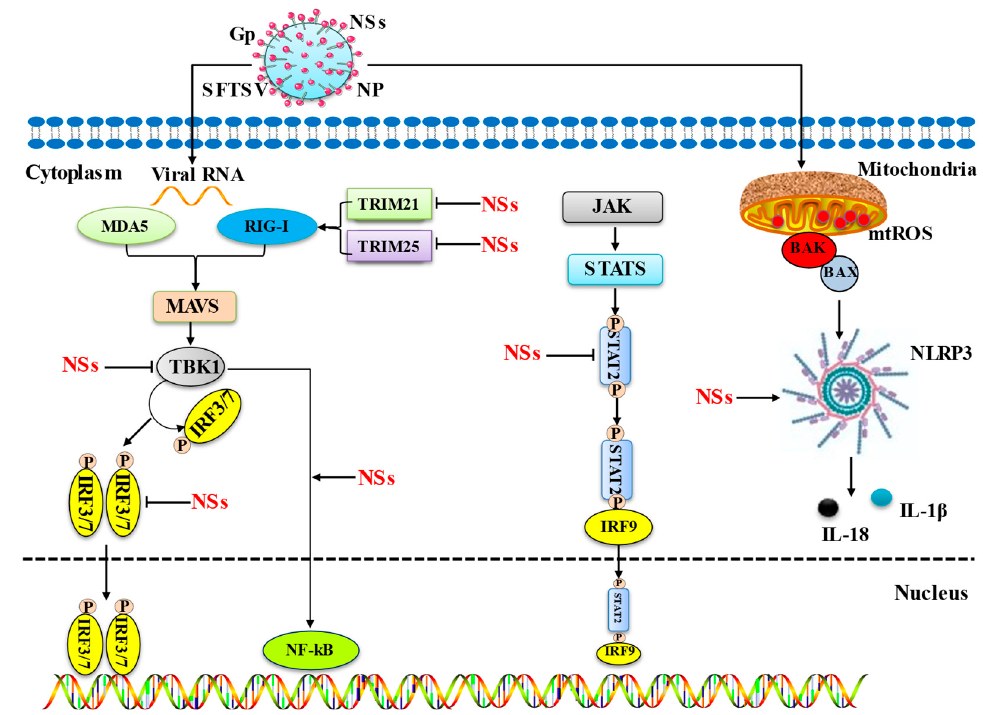
Figure 1. Mechanisms by which SFTS inhibits key immune signalling pathways and promotes inflammation. This diagram illustrates the main mechanism by which the host cell pathway is impacted by the NS proteins of SFTSV. Interferon release, the primary signaling mechanism for immune evasion, is inhibited by NSs in a number of ways, including the following: (1) NSs inhibit IFN production by isolating TRIM21/25, TBK1, STAT1/2, and IRF3/7 into their inclusion bodies. (2) Inhibition of the JAK/STAT signaling pathway, thereby inhibiting IFN production. The toxic NS proteins of SFTS induce inflammation through two pathways, including the following: (1) NSs produce inflammatory factors by promoting the transcription of NF-kB into the nucleus. (2) NSs trigger BAK upregulation and BAX activation through infection, leading to mitochondrial DNA oxidation and subsequent cytosol release and triggering NLRP3 inflammasome activation, which leads to inflammatory factor